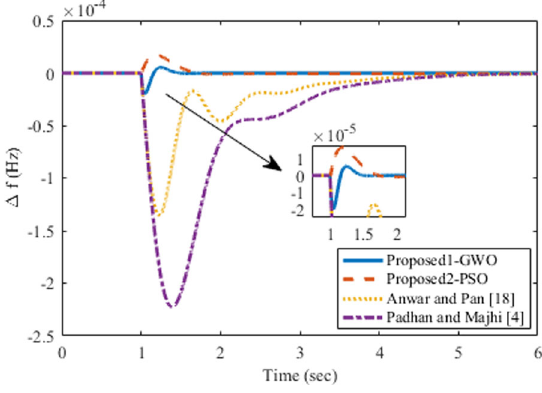
Fig. 4 Frequency regulation for case study